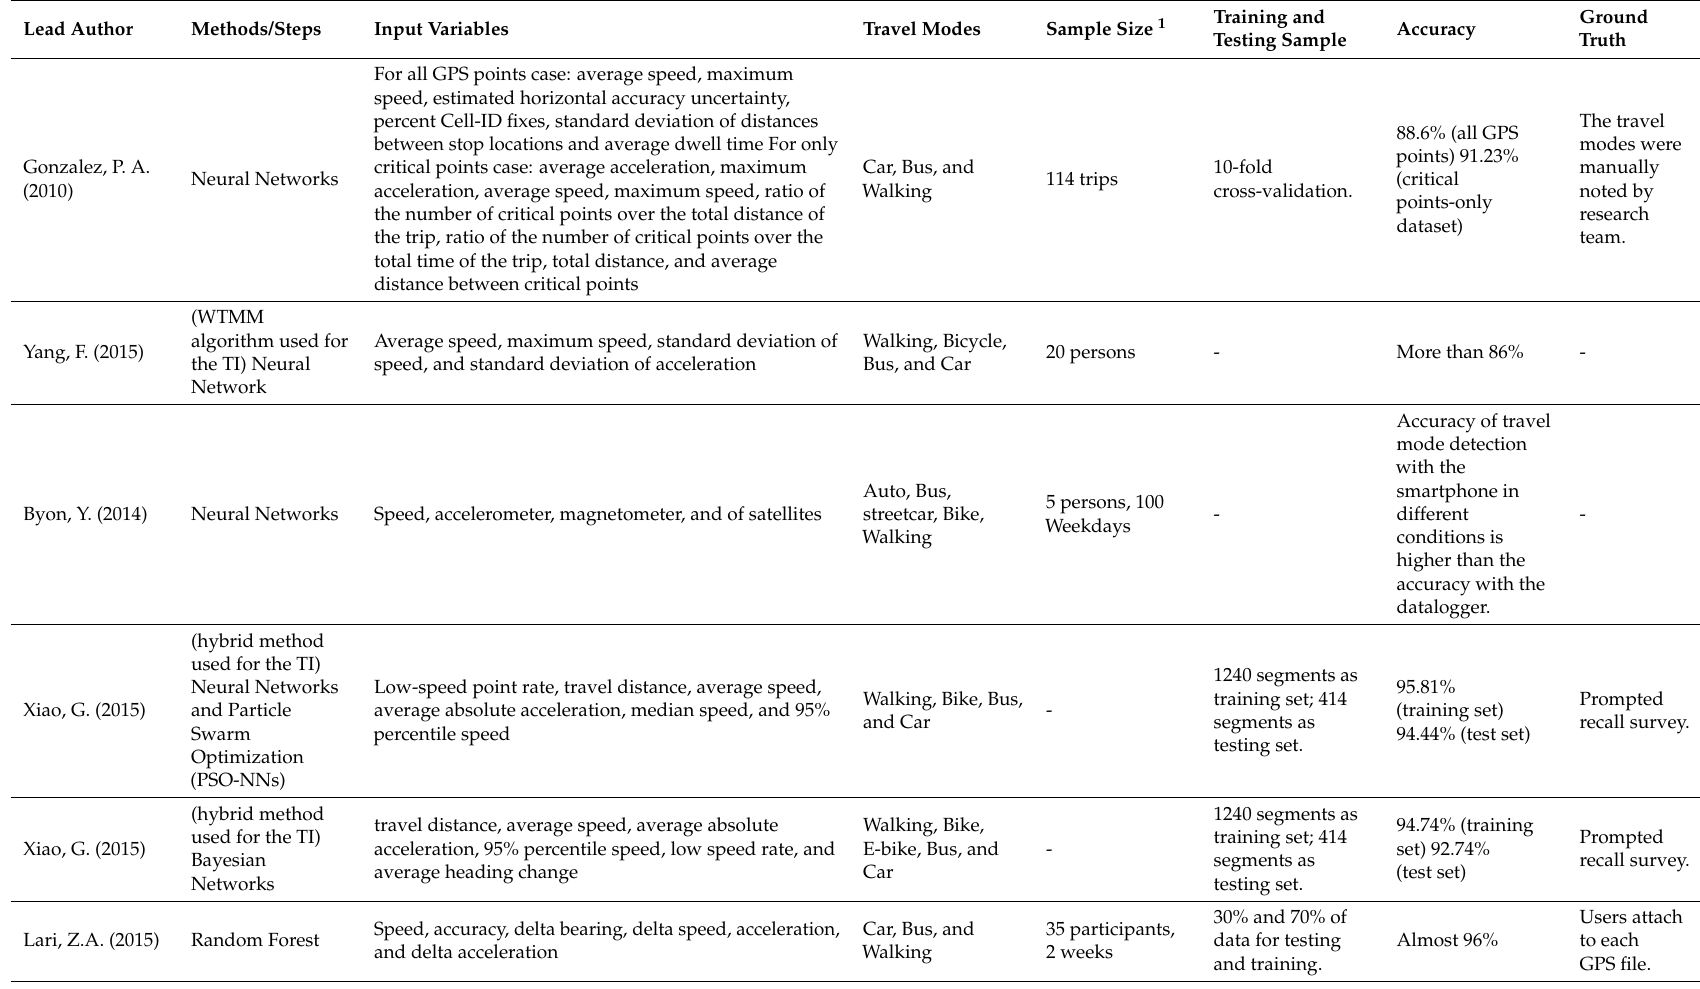
Table 5. Summary of methods of travel mode detection utilized in selected